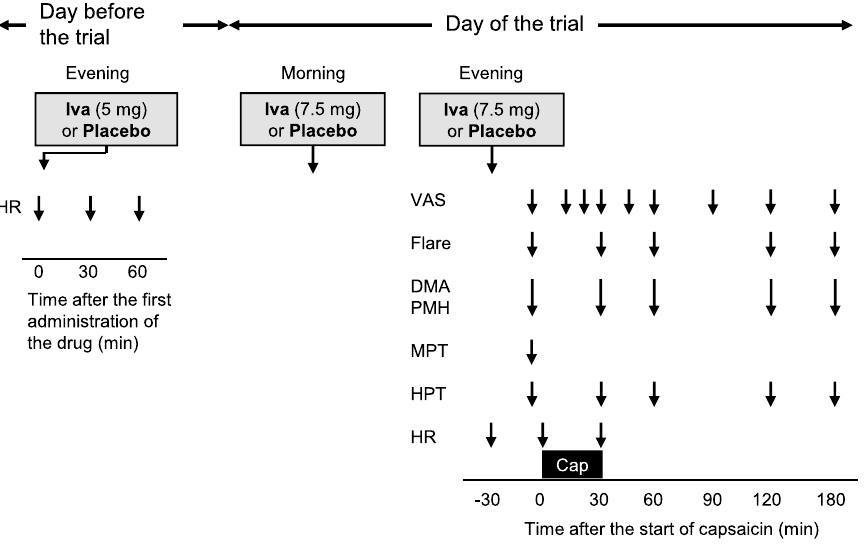
Figure 2. Timeline of the study period. Ivabradine (Iva) or a placebo was orally administered 3 times between the evening of the previous day and the evening of the trial day. Heart rate (HR) was measured before and